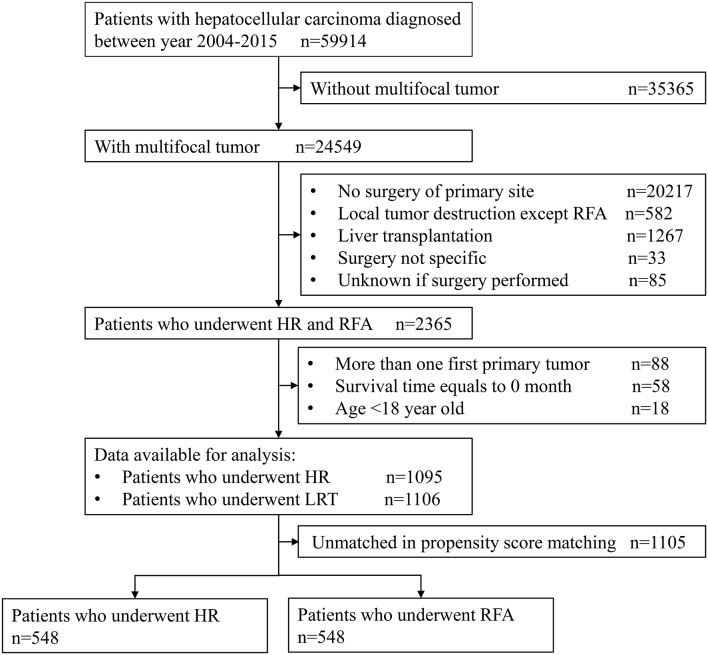
Flow chart of the sample selection procedure.